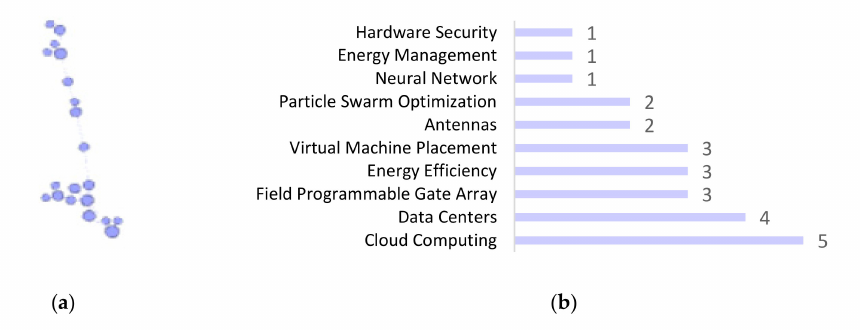
Figure 23. Community representation Cloud Computing: ( a ) Isolated distribution of publications. ( b ) Keywords of the